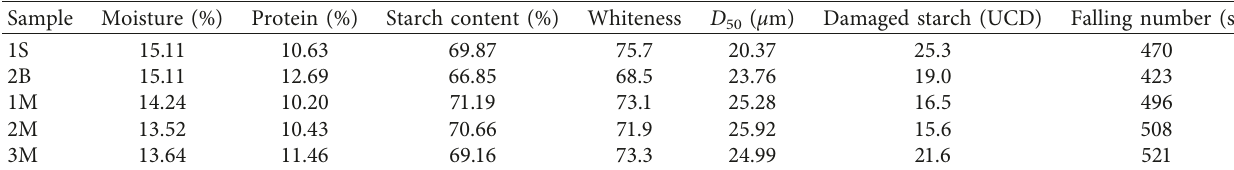
Note. S, sizing flour; B, break flour; M, reduction